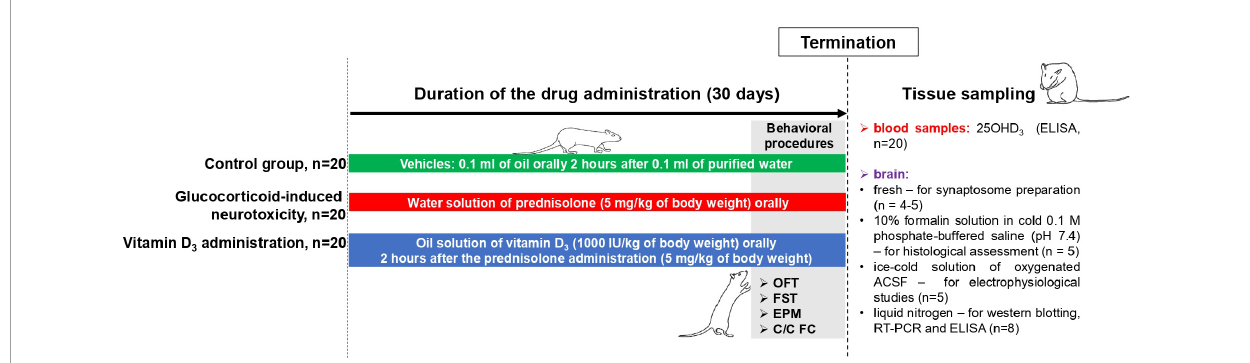
FIGURE1 Schematic representation of the experimental design and timescale. Each experimental group included 20 animals: (1) The control group that received purified water (0.1 ml) and oil solution (0.1 ml) as vehicles; (2) the group with glucocorticoid-induced neurotoxicity, in which rats received orally the water solution of synthetic glucocorticoid prednisolone (Biopharma, Ukraine) at a dose of 5 mg/kg of body weight (30 days) and additionally oil solution (0.1 ml) as vehicle; (3) the group that received the oil solution of vitamin D 3 (Sigma-Aldrich, USA, C9756) at a dose of 1,000 IU/kg of body weight per os (30 days) on the background of prednisolone administration (5 mg/kg of body weight). Behavioral procedures (OFT, open-field test; FST, forced swim test; EPM, elevated plus maze; C/C FC, contextual/cued fear conditioning test) were performed during 3 days before the decapitation with the concurrent drug administration ( n = 8 per group). At the end of the experimental treatment, the rats were anesthetized by an intraperitoneal injection of chloral hydrate (40 mg/100 g of body weight), decapitated with a guillotine. Blood samples were taken from the inferior vena cava to measure 25OHD 3 by ELISA ( n = 20 per group). The whole brain was quickly dissected and was used fresh (for synaptosome preparation, n = 4–5) or transferred into the appropriate buffer depending on the procedures: 10% formalin solution in cold 0.1 M phosphate-buffered saline (pH 7.4)—for histological assessment ( n = 5 per group); an ice-cold solution of oxygenated (95% O 2 , 5% CO 2 ) artificial cerebrospinal fluid (ACSF) solution (119 mM NaCl, 2.5 mM KCl, 2.0 mM CaCl 2 , 1.3 mM MgCl 2 , 26 mM NaHCO 3 , 1.0 mM NaH 2 PO 4 , 11 mM